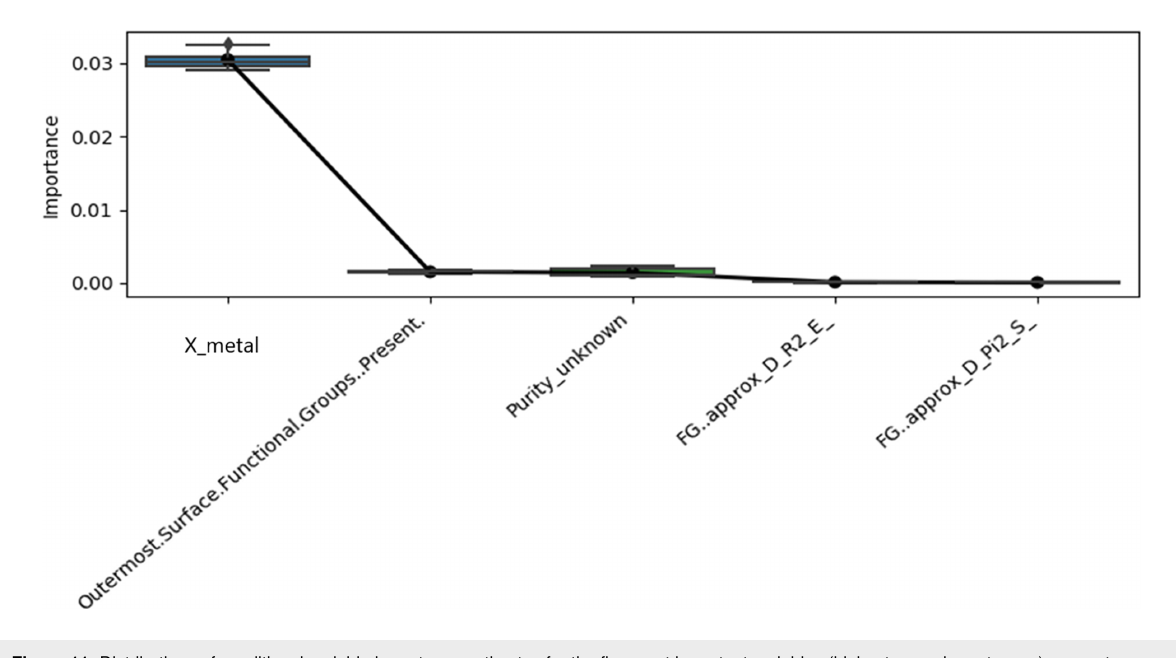
Figure 11: Distributions of conditional variable importance estimates for the five most important variables (highest mean importances) across ten Cforest multiple descriptor models, built without data augmentation on the original model development dataset, of excess lethality at 120 hpf. The mean variable importance measures (black circles) are superimposed upon the boxplots of the distributions. The descriptors with names beginning with “FG” represent descriptors calculated for the neutral molecular structures of the outermost functional groups. “X_metal” denotes the Pauling metal atom electronegativity descriptor. See section “Descriptor calculations” under the Experimental section for detailed explanations of the names of the other